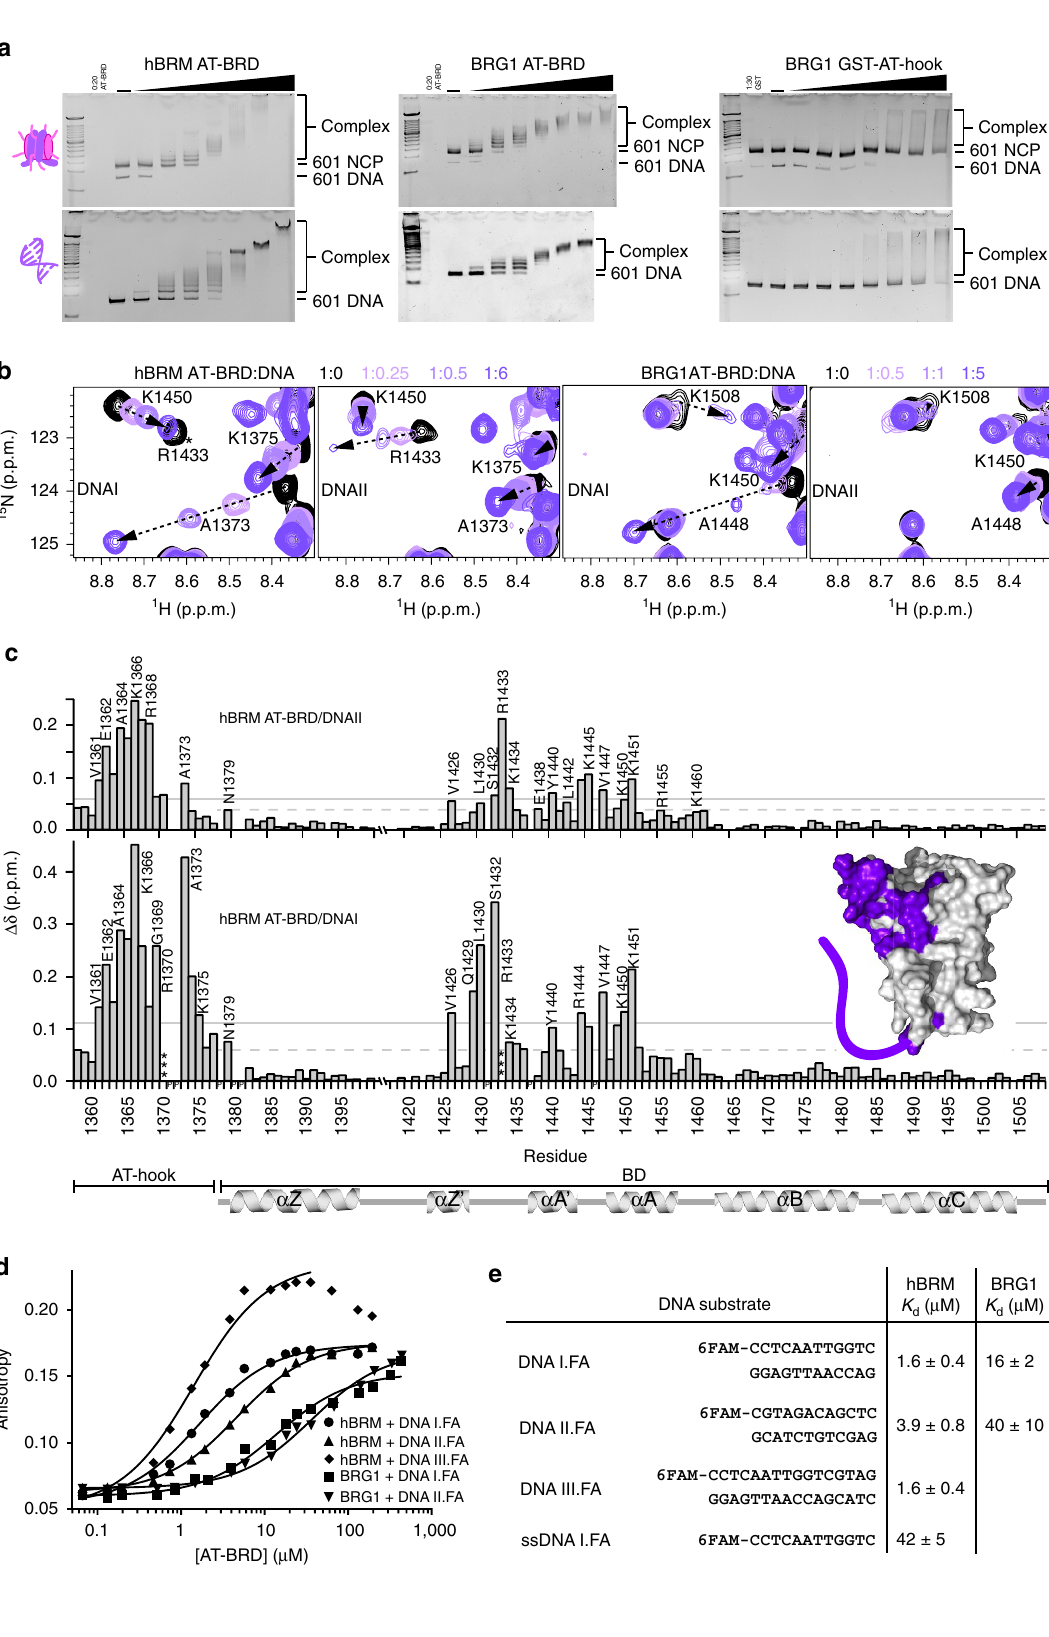
DNA I.FA DNA II.FA